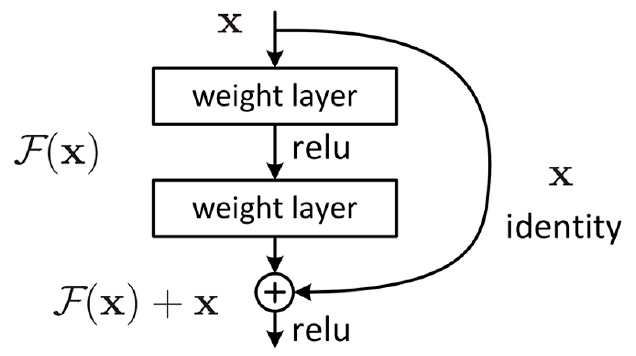
Figure 6. Building block of ResNet.